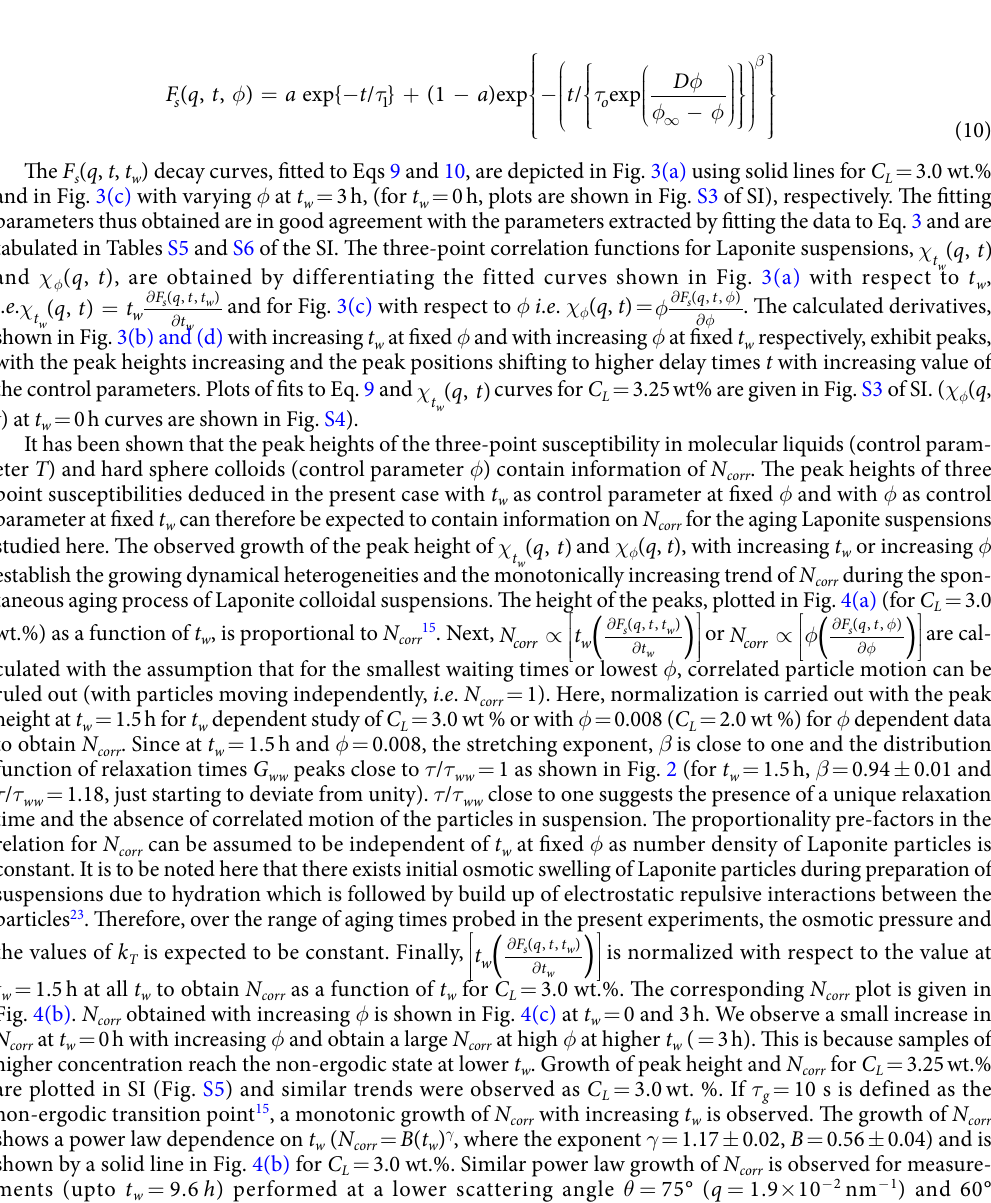
= 0 and 3 φ at t corr vs. w